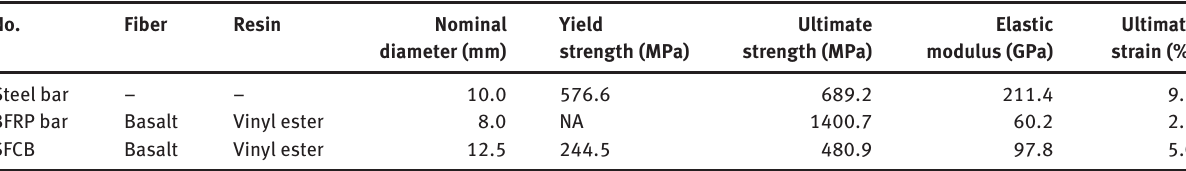
Table 1: Tested properties of the reinforcing bars.